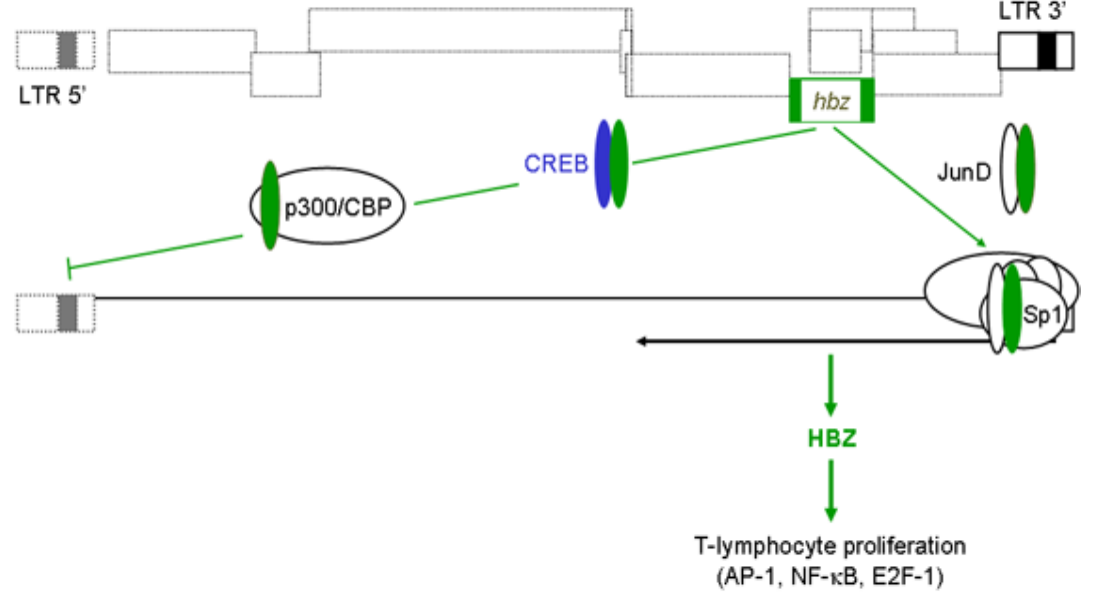
Figure 2. Regulation of sense and antisense transcription by HTLV-1 basic leucine zipper (bZIP) factor (HBZ). Antisense transcripts initiated from the 3' LTR are responsible for encoding the HBZ protein. HBZ then downmodulates Tax-dependent viral gene expression by interacting with CREB and p300/CBP. HBZ could also activate its own expression by forming HBZ/JunD heterodimers able to interact with the Sp1 transcription factor bound to the Sp1-binding sites involved in the stimulation of antisense transcription. HBZ would thus render the infected cells less likely to be targeted by the immune response through lower expression of viral proteins but should also promote T-lymphocyte proliferation by controlling cellular transcription through AP-1, NF-  B and E2F-1